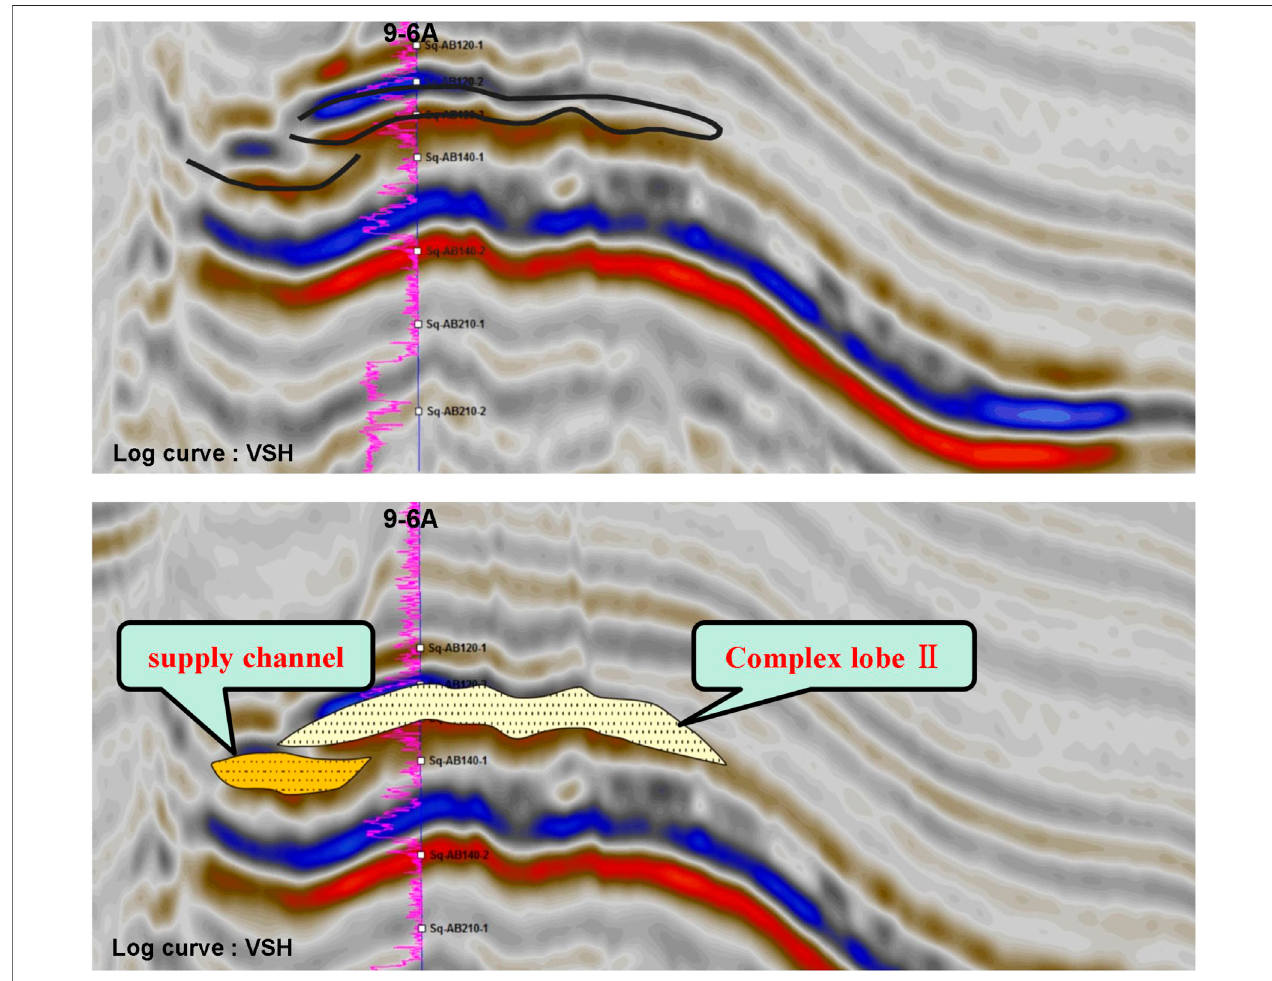
FIGURE 15 | Well-log and seismic responses of the AB120 reservoir in the direction perpendicular to the source direction.